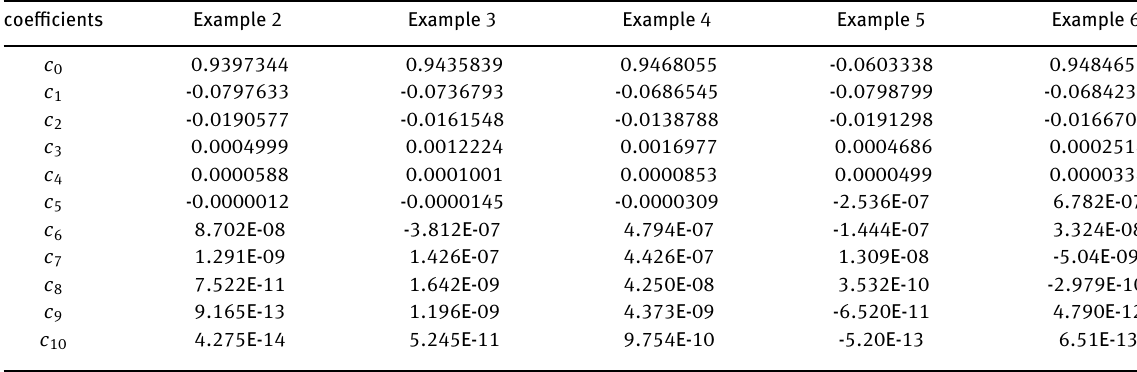
Table 5: The value of the unknowns vector C T for discussed examples for N = 10